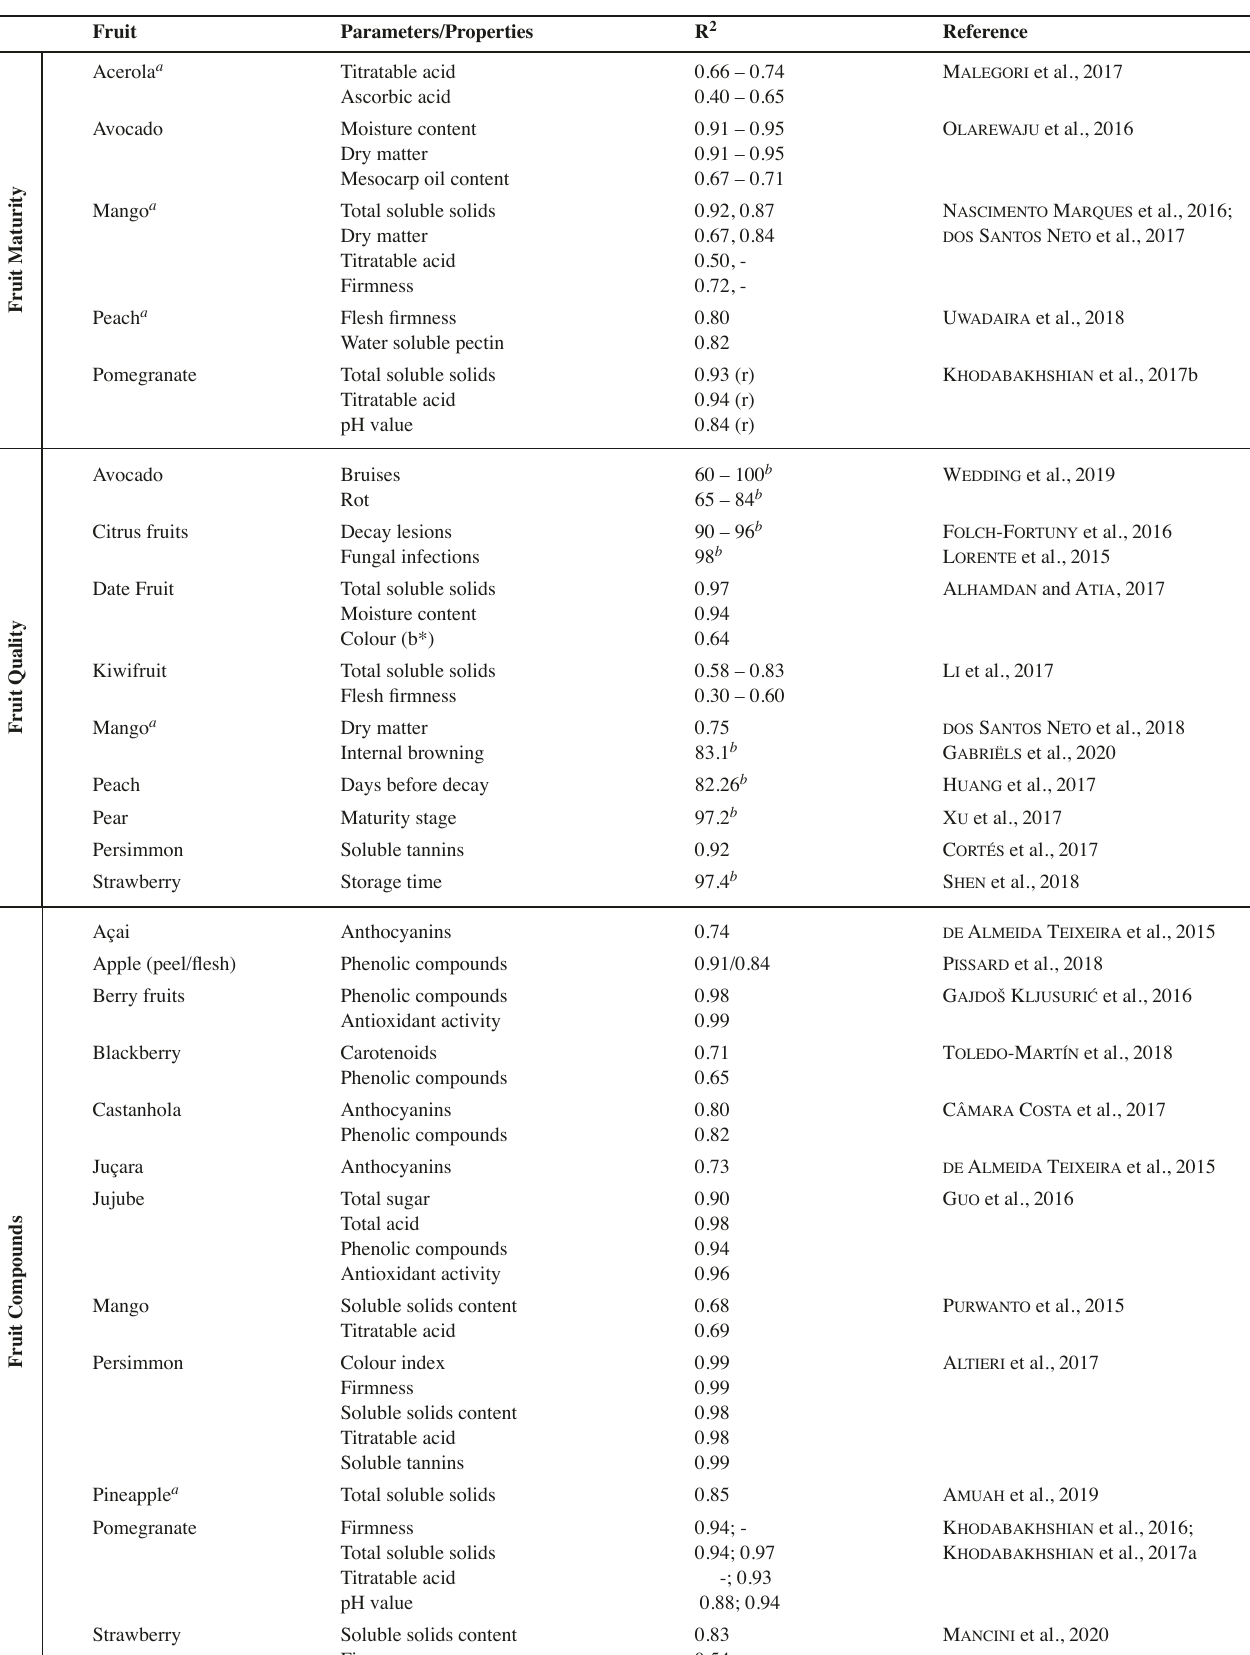
Tab. 1: Applications of NIR spectroscopy in fruit analysis